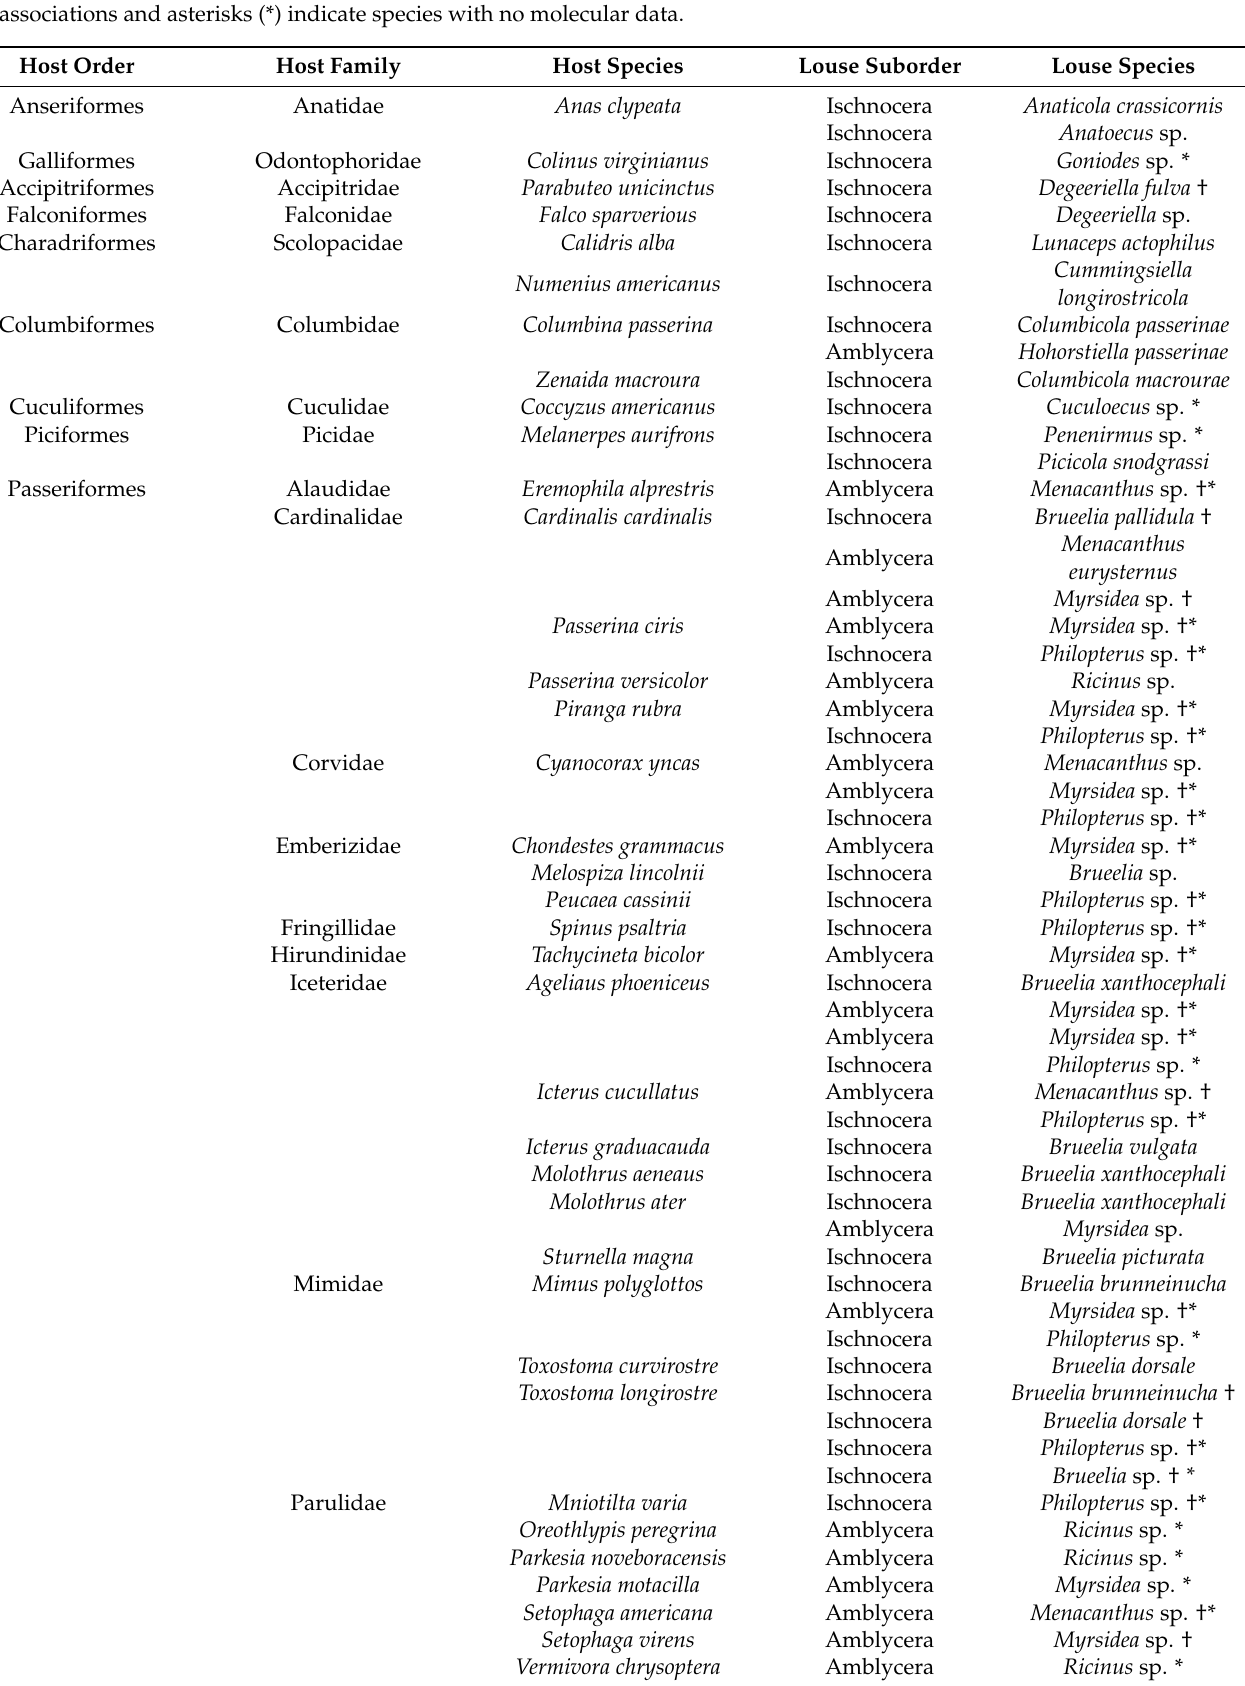
Table 2. Louse–host associations of birds sampled from South Texas during 2013–2015. Daggers (†) indicate new host associations and asterisks (*) indicate species with no molecular